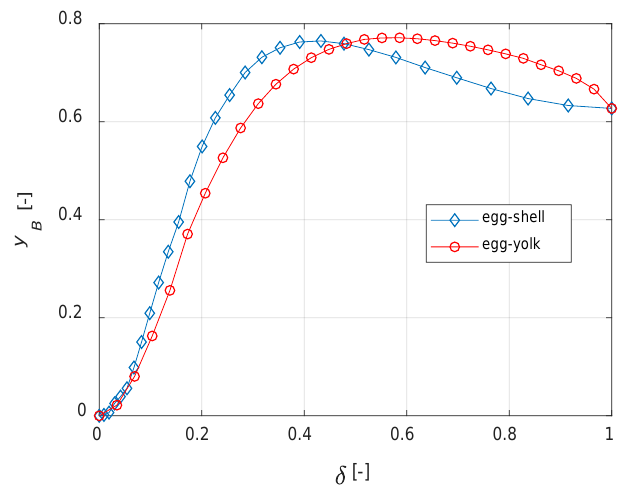
Figure 11. Egg-shell vs. egg-yolk: comparisons.